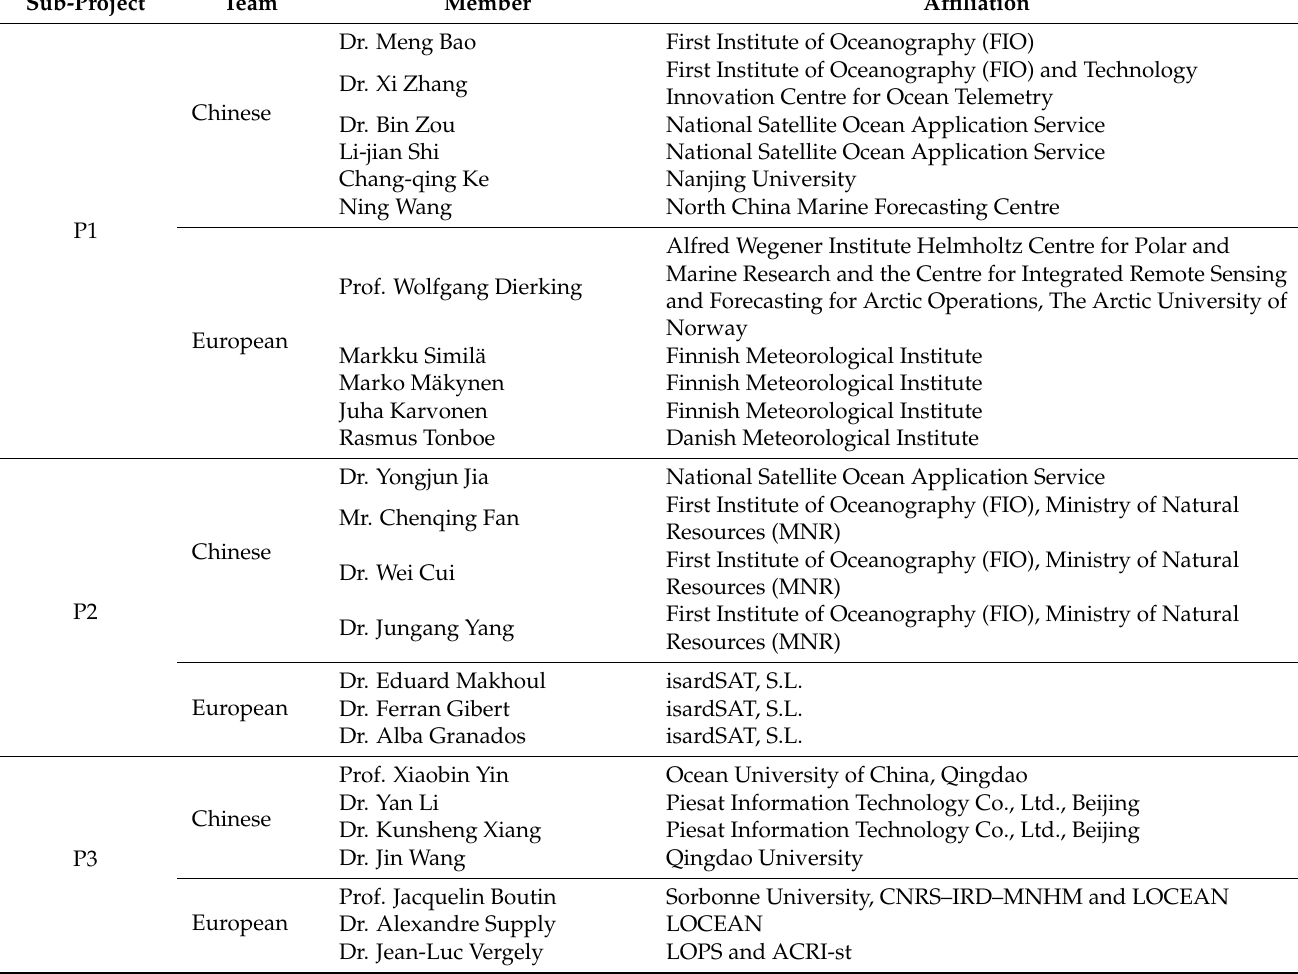
Table A1. List of members of the different